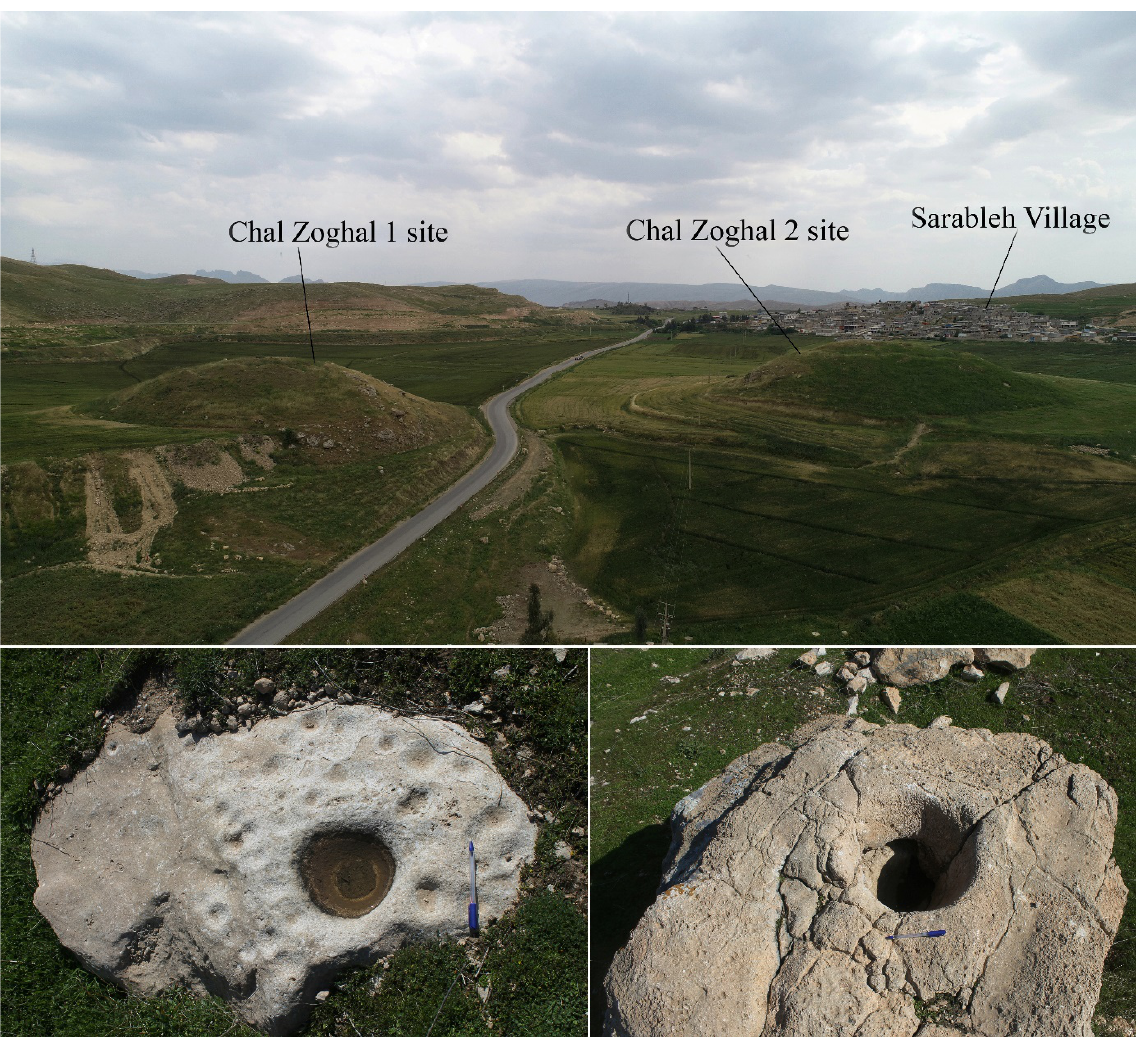
Figure 9. Aerial view of Chal Zoghal 1 and its rock mortars (courtesy of Reza